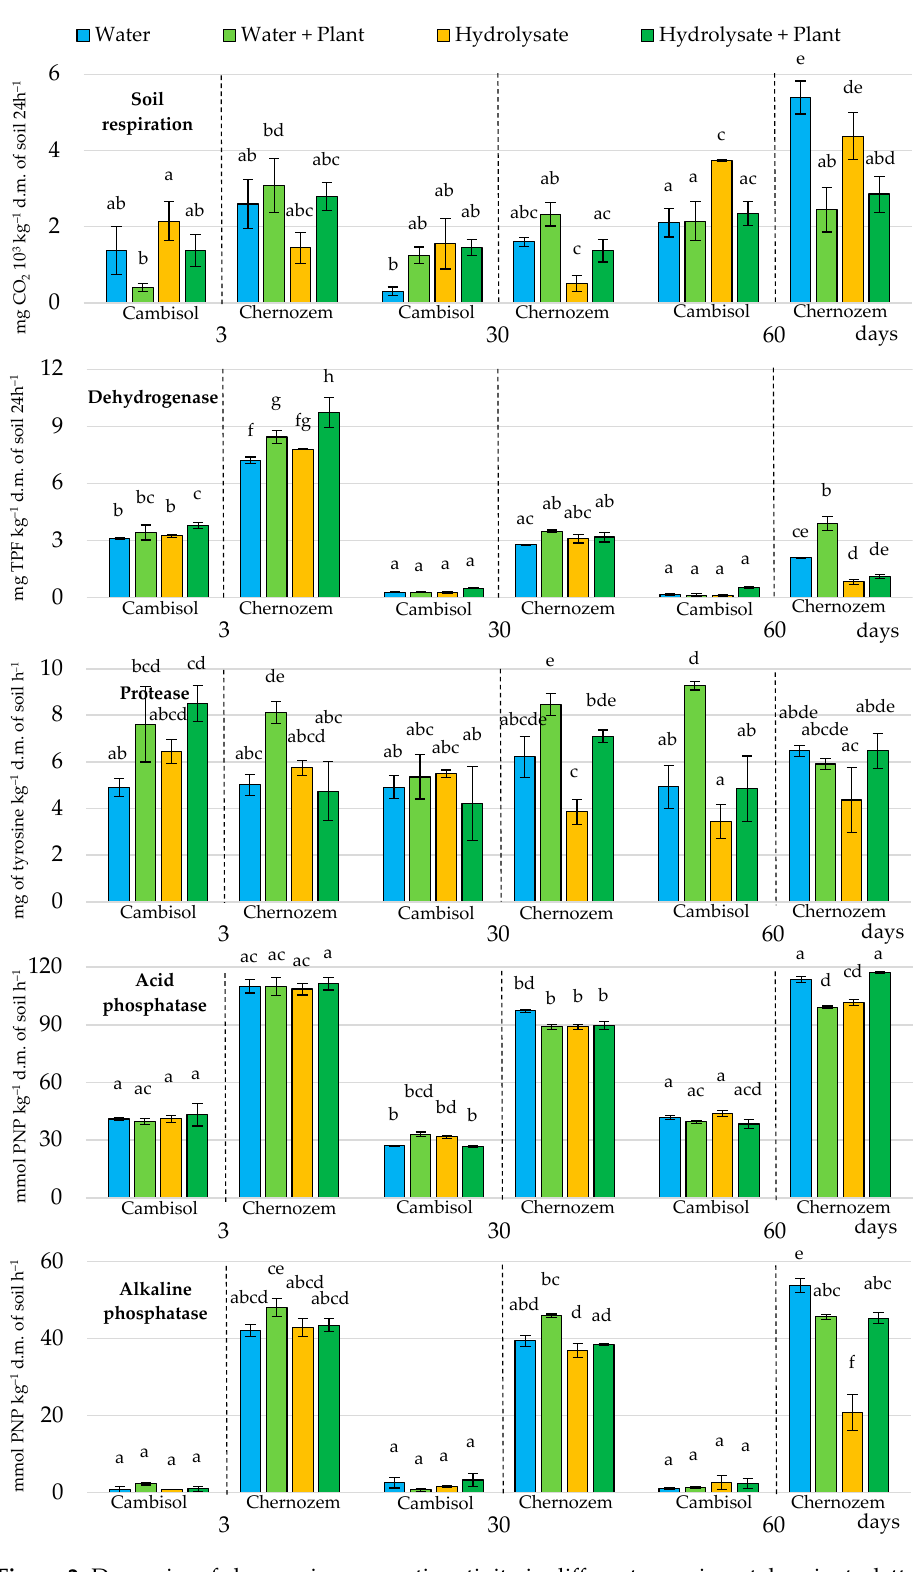
Figure 2. Dynamics of changes in enzymatic activity in different experimental variants; letters, i.e., a, b, c, d denote the means that form homogenous groups (HSD–Tukey post hoc test for multivariate ANOVA). When two compared means were assigned the same letter (e.g., a, a or ab, ab) that means did not differ significantly (at α = 0.05); if means are marked with different letters (e.g., a and b, etc.) they differ significantly from each other (at α =